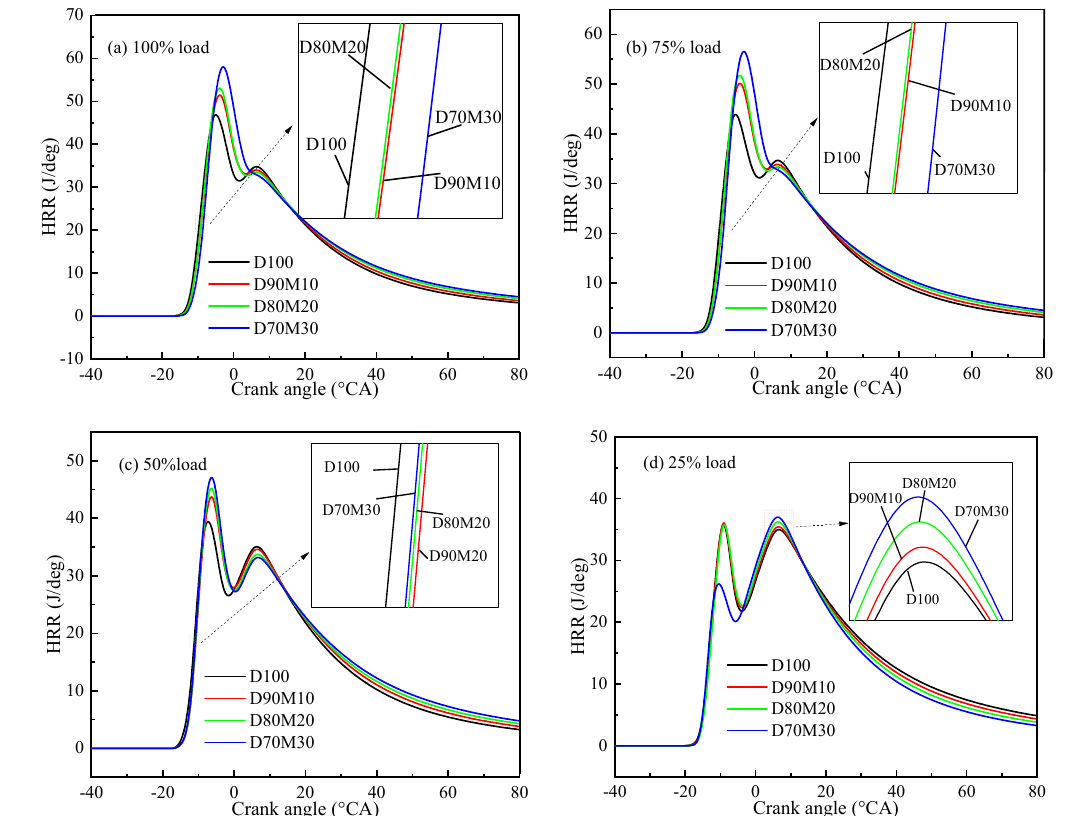
Figure 7. Heat release rate curves of different proportions of diesel–methanol blended fuel under different load conditions. ( a ) at 100% load, ( b ) at 75% load, ( c ) at 50% load, ( d ) at 25% load.